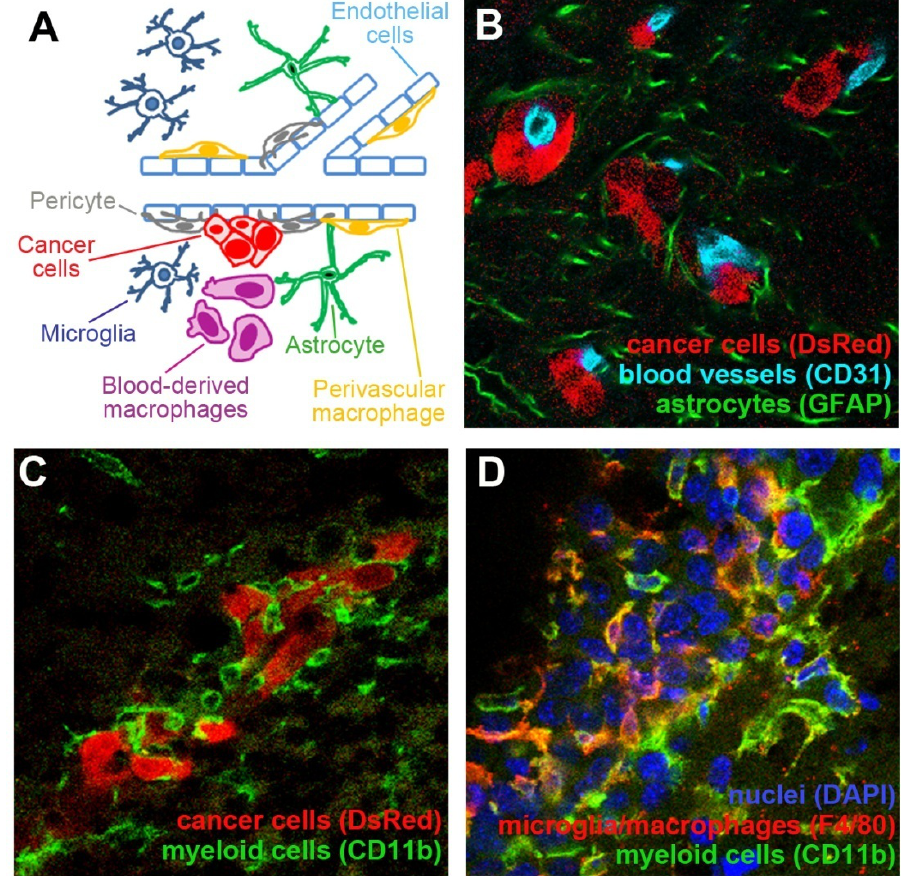
Figure 1. Tumor microenvironment in the brain consists of different cell types. ( A ) Schematic representation of some major cell types that constitute tumor microenvironment in the brain. ( B ) Mouse breast carcinoma cell line EO771 that stably expresses red fluorescent protein (DsRed; red) metastasized to the brain upon the administration of cancer cells into the internal carotid artery. Extravasated cancer cells remained associated with the blood vessels (light blue). The presence of cancer cells induced a strong activation of astrocytes, as demonstrated by their increased expression of GFAP (green). ( C ) Small metastatic lesions of EO771 cells (red) are surrounded by CD11b + cells of myeloid origin with different morphologies (green). ( D ) A larger metastatic lesion established by EO771 cells (nuclear staining in blue) is infiltrated by CD11b + myeloid cells (green). Some of